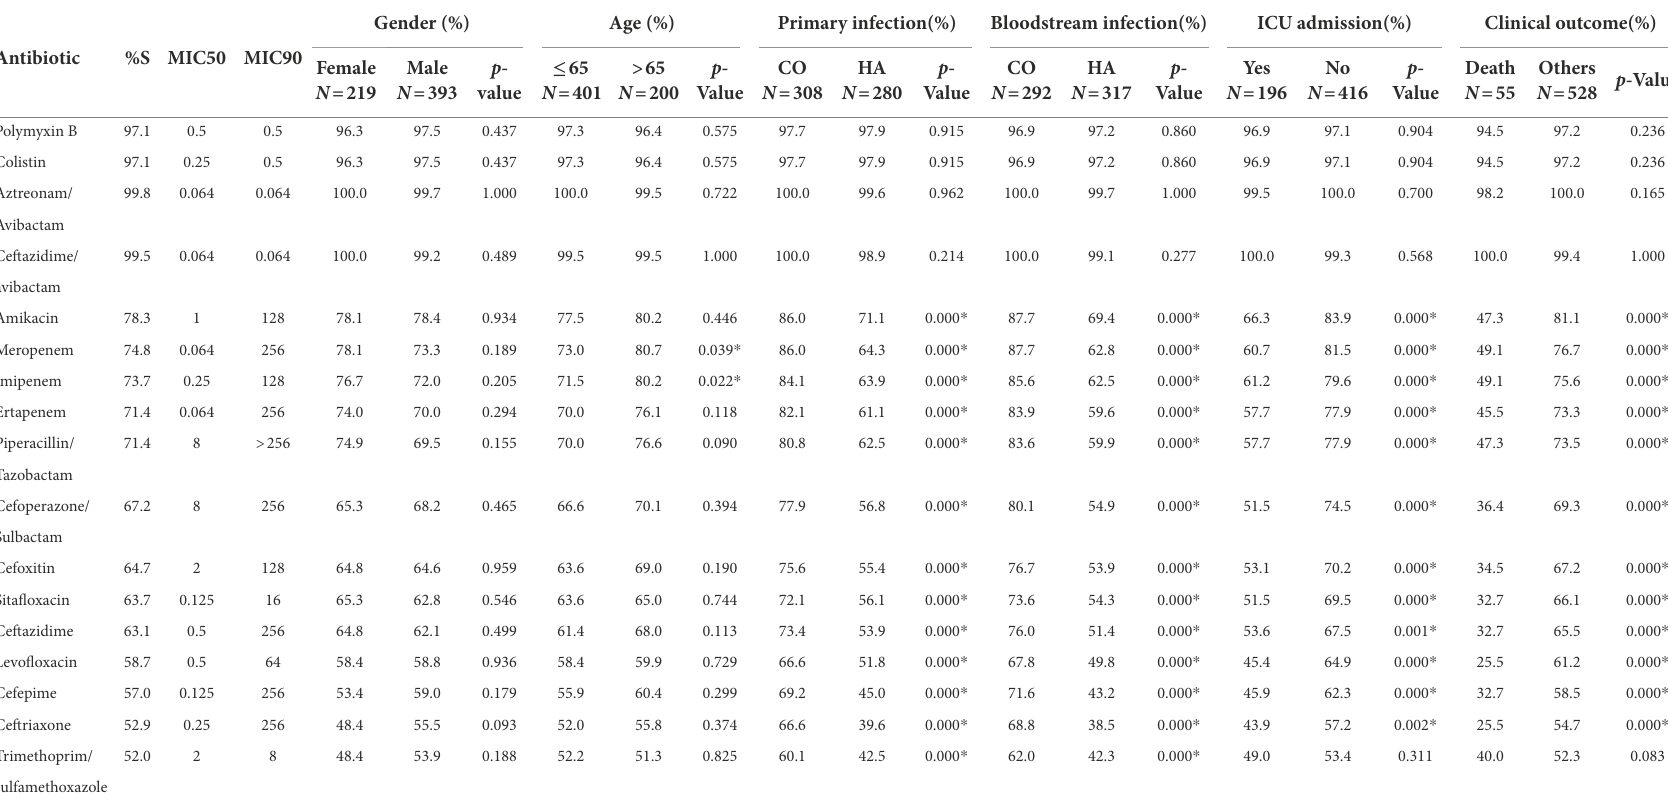
TABLE 2 Comparison of the antimicrobial susceptibility rates of K. pneumoniae isolates in clinical features.